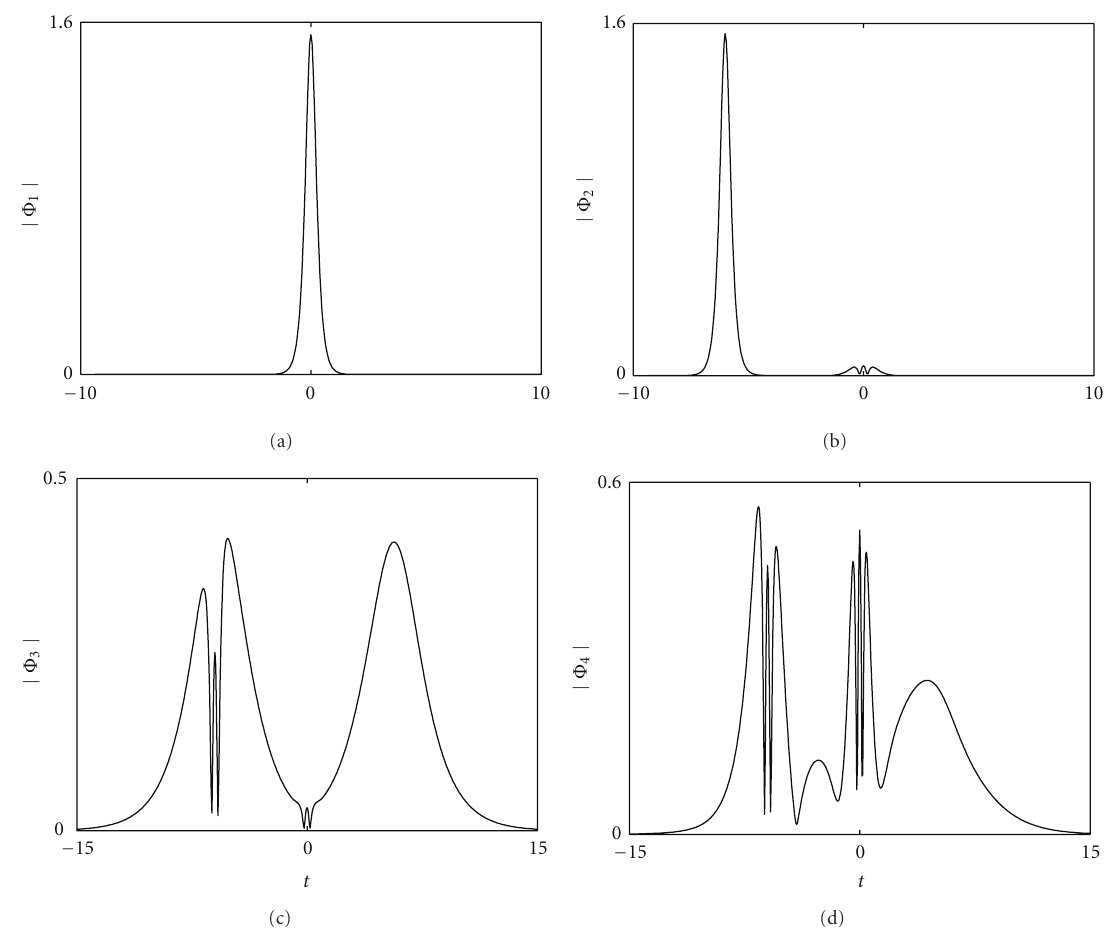
Figure 7: Basis functions used in the (1 + 3) model. These functions are obtained by applying the Gram-Schmidt algorithm to the set S = { φ (1) 1 , φ (2) 1 , φ (2) 2 , φ (2) 3 }